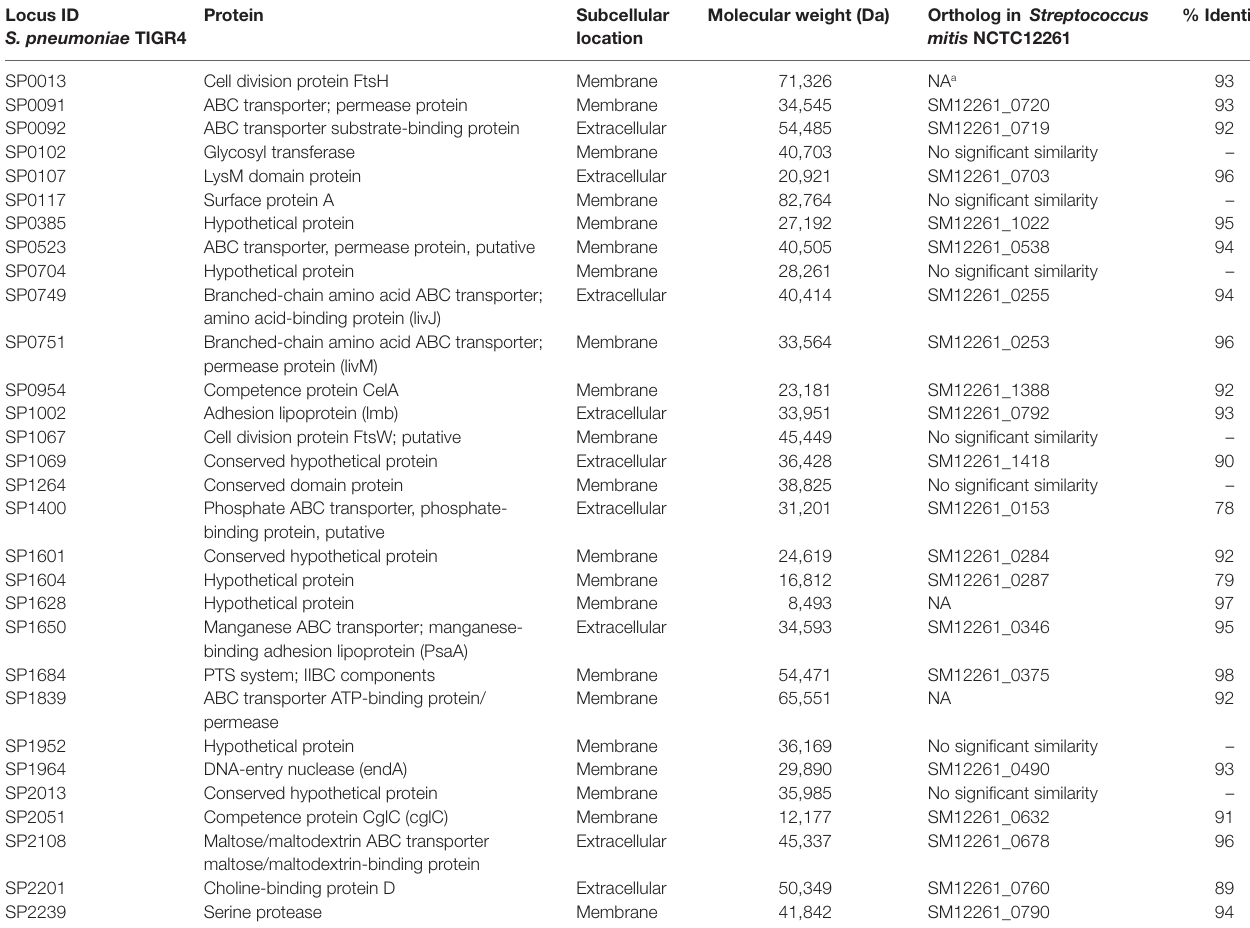
TaBle 1 | List of Streptococcus pneumoniae proteins selected for on-chip protein microarray experiments. locus iD S. pneumoniae Tigr4